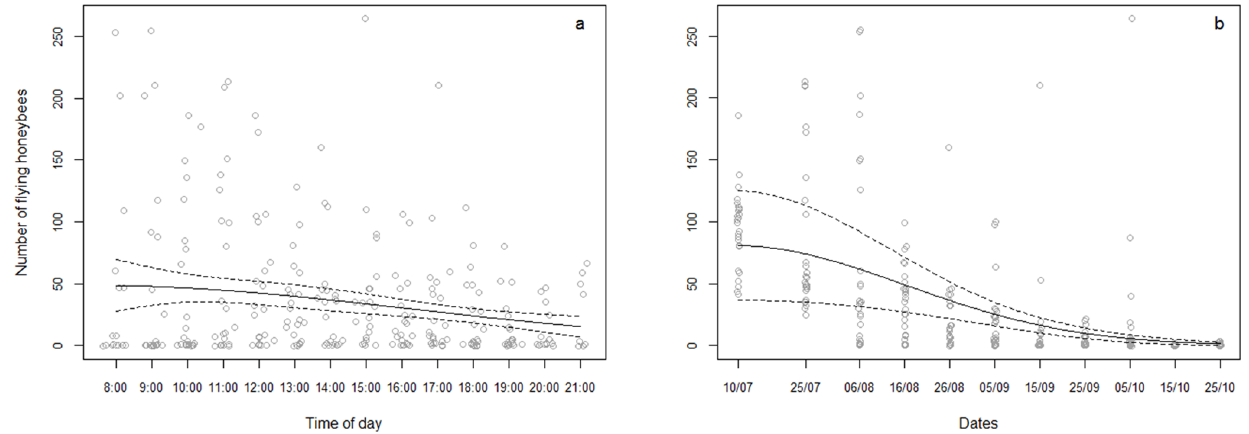
Figure 5. Variation of the number of flying Apismellifera during a) the day and b) the season. The data are pooled for H1 and H2. Predicted values fitted with the GLM model (plain line) with 95% confidence interval (dash lines).